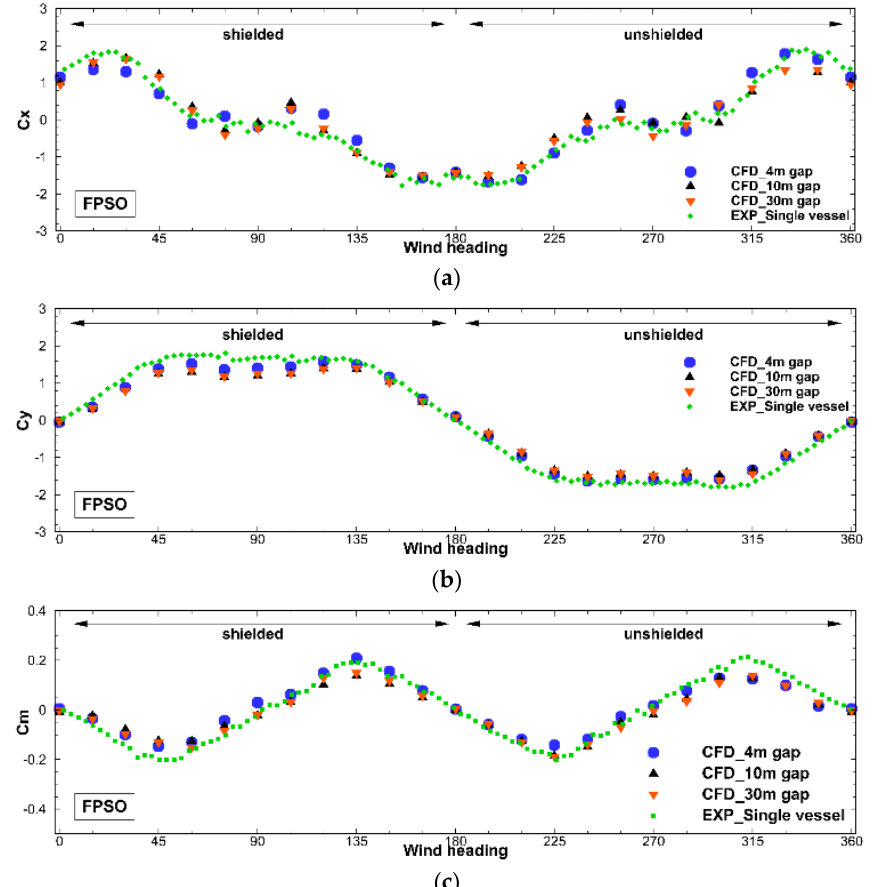
Figure 20. Comparison between single-vessel case and side-by-side case with different gaps for the FPSO. ( a ) 𝐶 𝑥 ; ( b ) 𝐶 𝑦 ; ( c ) 𝐶 𝑚 .